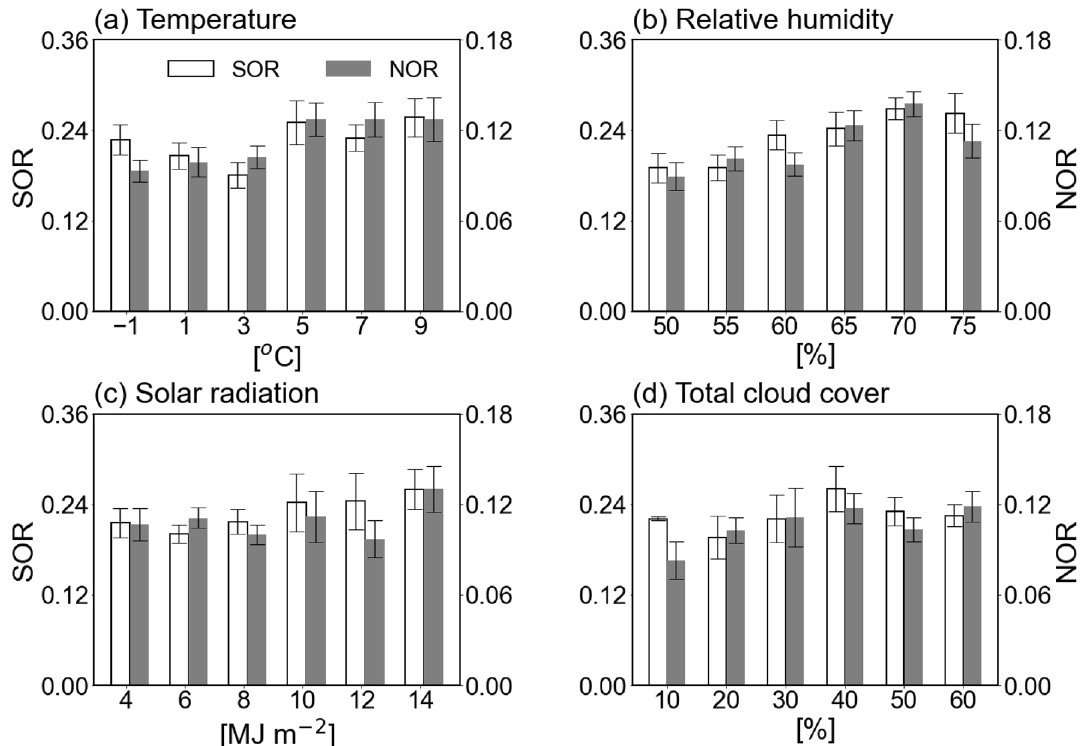
Figure 1. Tow oxidation ratios—SOR and NOR—corresponding to ( a ) temperature, ( b ) relative humidity (RH), ( c ) solar radiation, and ( d ) total cloud cover during high-PM 2.5 episodes. The mean values are shown as the bars with ± 1 standard